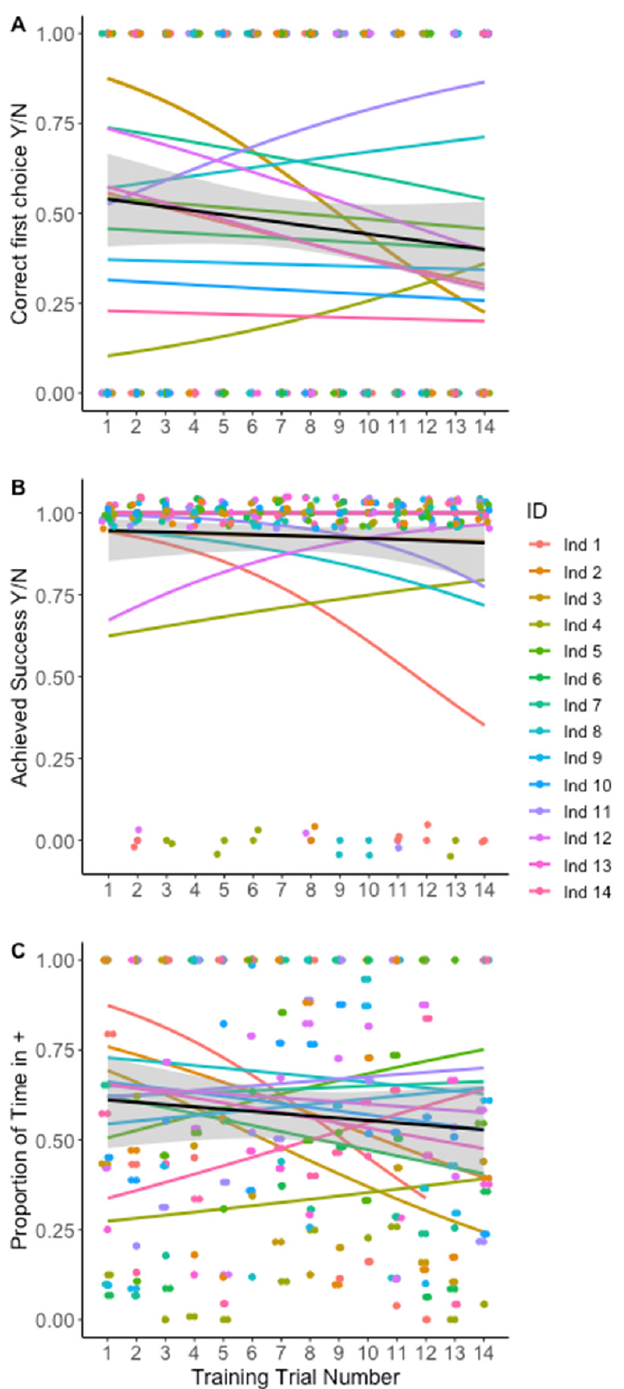
Figure 2. Measurements of training trial success for Experiment 1—Within modality ‘sameness’ assay. ( A ) Likelihood of the focal amblypygid first entering into the C+ region from the neutral area. Individuals did not improve their first choice performance during training. ( B ) Likelihood of entering the C+ door in the 20 min time limit (successful training trial). Individuals did not improve in proportion of successful trials over time. ( C ) Proportion of time spent in C+ area out of total time spent outside the neutral zone. A value of 0.5 indicates equal time in the C+ and C − areas of the arena. Individuals did not increase the proportion of time spent associating with the C+ stimulus.